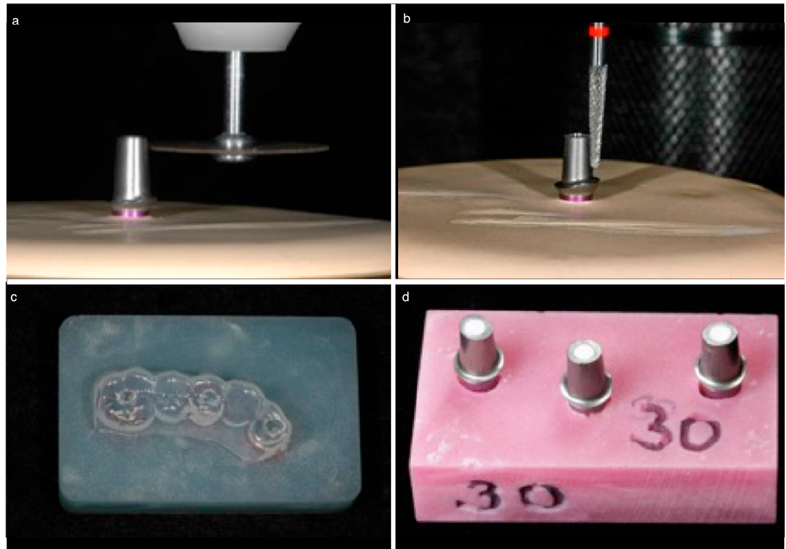
Figure 1. Production of implant models. ( a ) Use of a cutting disk adjusted to shorten the abutment to a length of 6 mm; ( b ) use of a bur adjusted to mill a tapered groove at length of 5 mm and depth of 0.5 mm for anti-rotation lock ( c ) Placement of the deep-drawn film (teeth 12, 14, 16) for optimal positioning of the implants in the methacrylate block, ( d ) parallel-placed lab analogs with mounted abutments in one of the 24 models (2 × 4 × 1 cm).